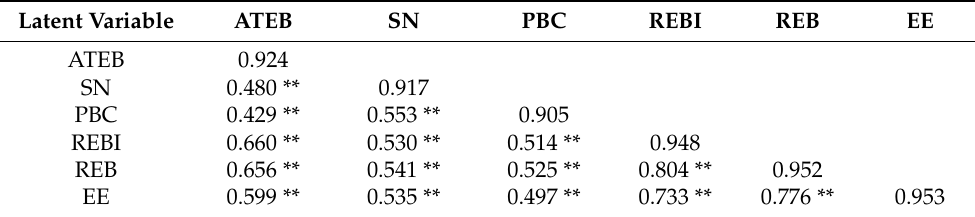
Table 8. Discriminant validity test applied in our